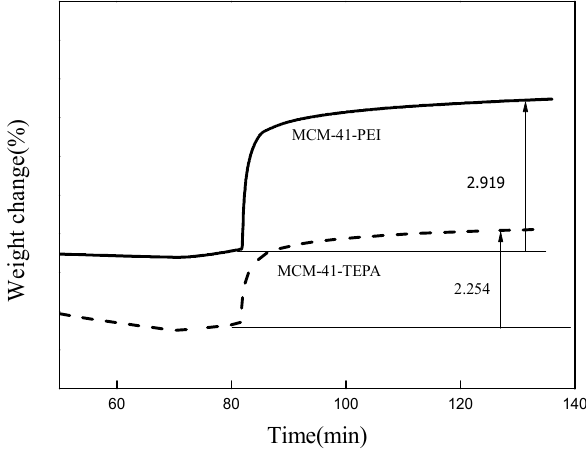
Figure 4. CO 2 adsorption curves of MCM-41-TEPAand